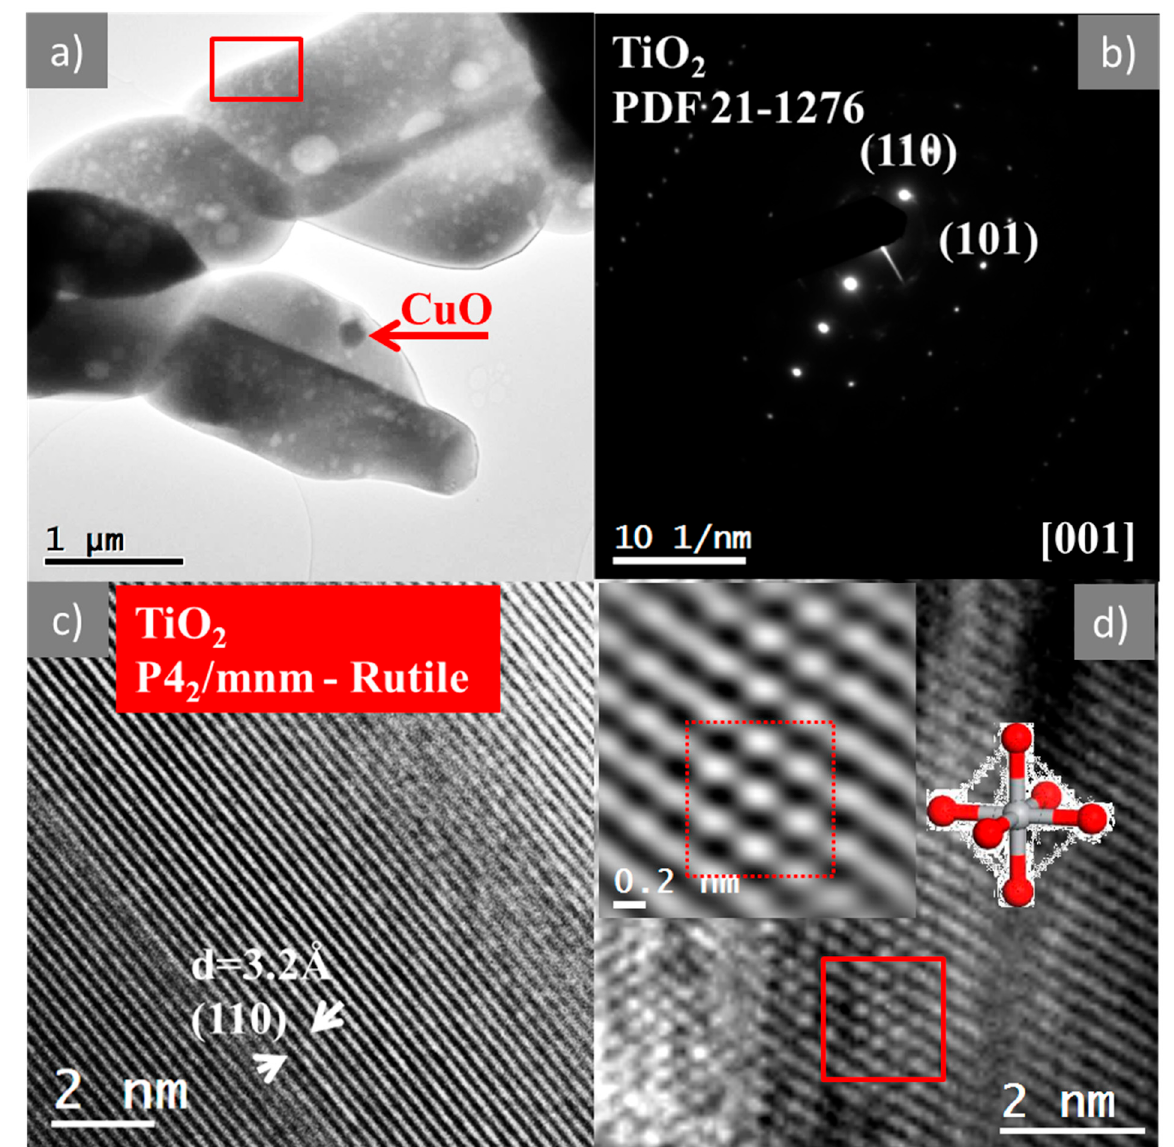
Figure 10. HRTEM analysis of sample Cu/TiO 2 _950 ( a ) Cu/TiO 2 _950 with a magnification of 1 μ m, ( b ) Cu/TiO 2 _950 SAED pattern, ( c , d ) Cu/TiO 2 _950 with a magnification of 2 nm.